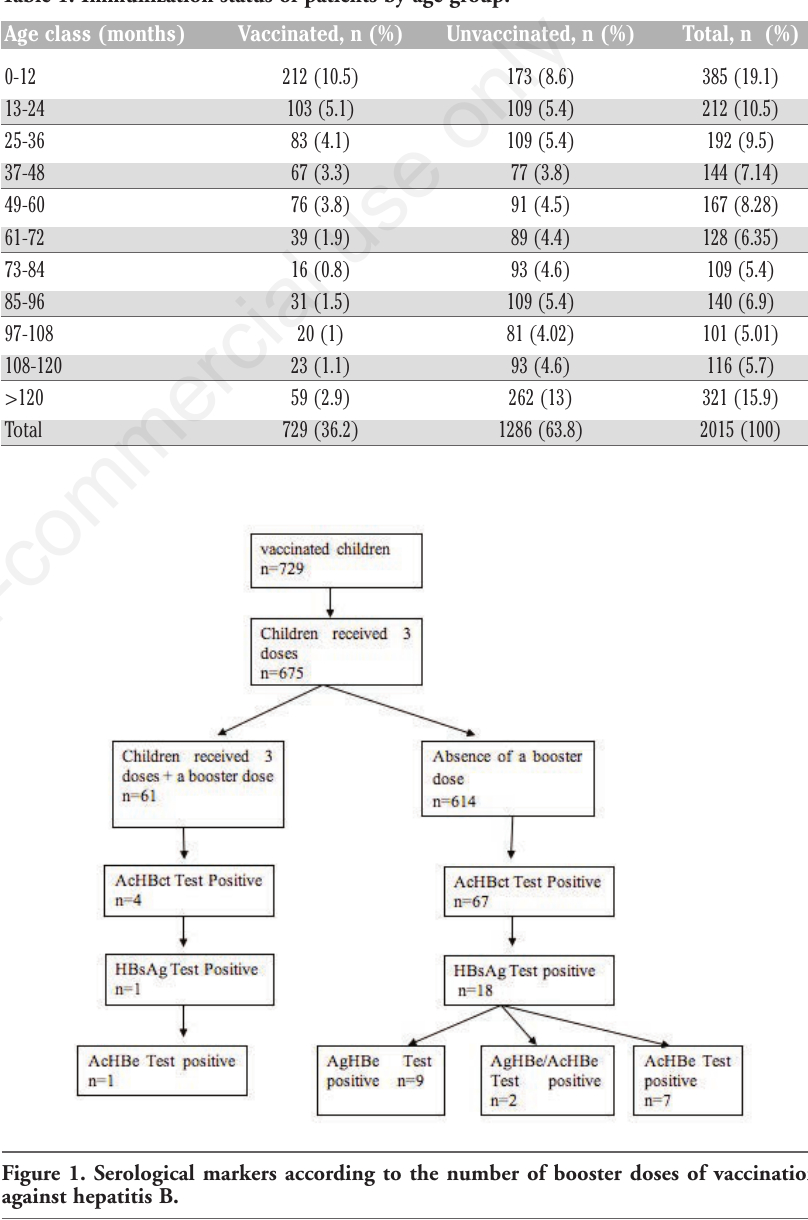
Table 1. Immunization status of patients by age